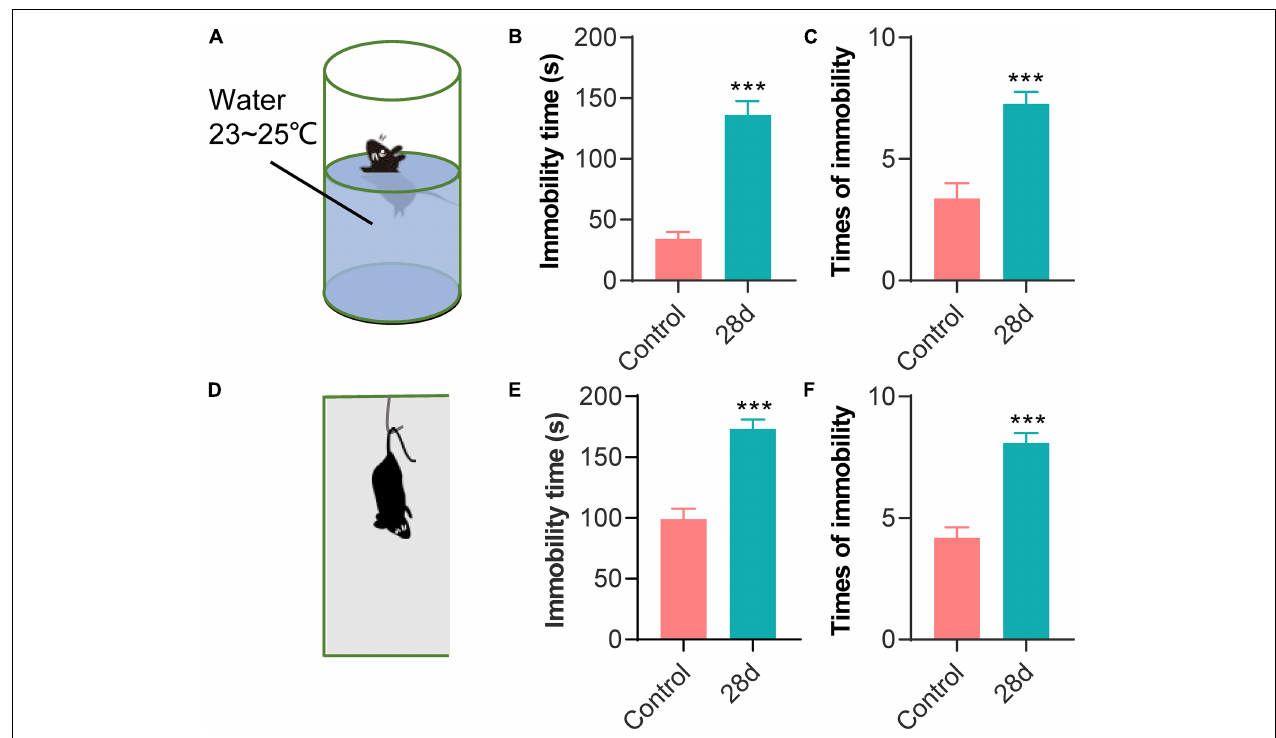
FIGURE 3 | FST and TST showed that the depressive-like behavior of the CEBS mice was obvious. Schematic diagram of FST (A) and TST (D) . Time (B) and times (C) of immobility in FST; time (E) and times (F) of immobility in TST. Data are presented as mean ± SEM or median (Interquartile range, IQR) from n = 11–12 mice/group (B,C,E,F) , *** P <